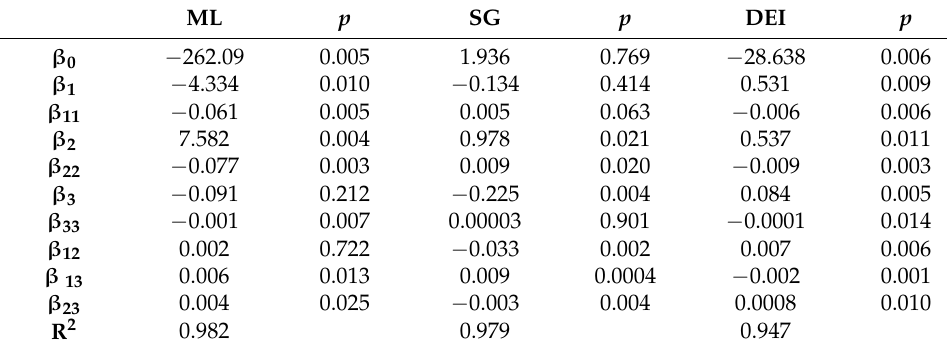
Table 3. Regression coefficients of the quadratic equation for ML, SG and